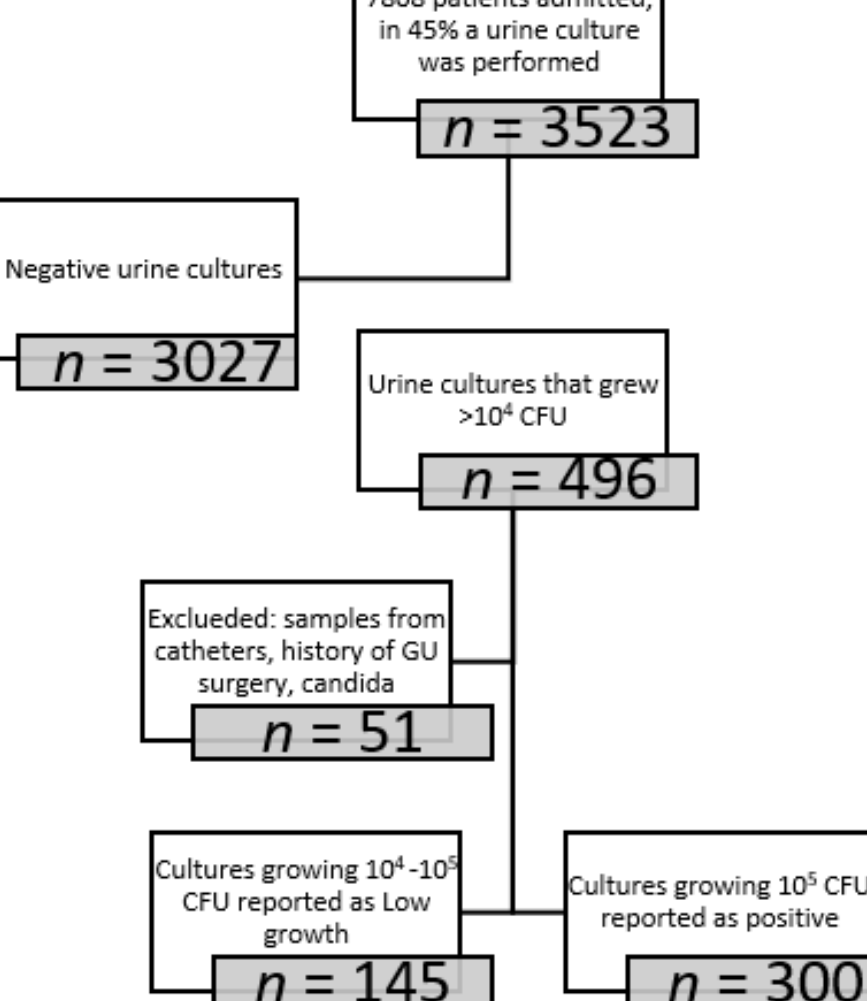
Figure 1. Flow chart of patients included in the study cohort who were admitted to the General Medical wards during a four-month period following an intervention to urine culture report policy. Table 2. Baseline patient characteristics comparing patients with urine culture that were reported as low growth to patients that were reported as positive.